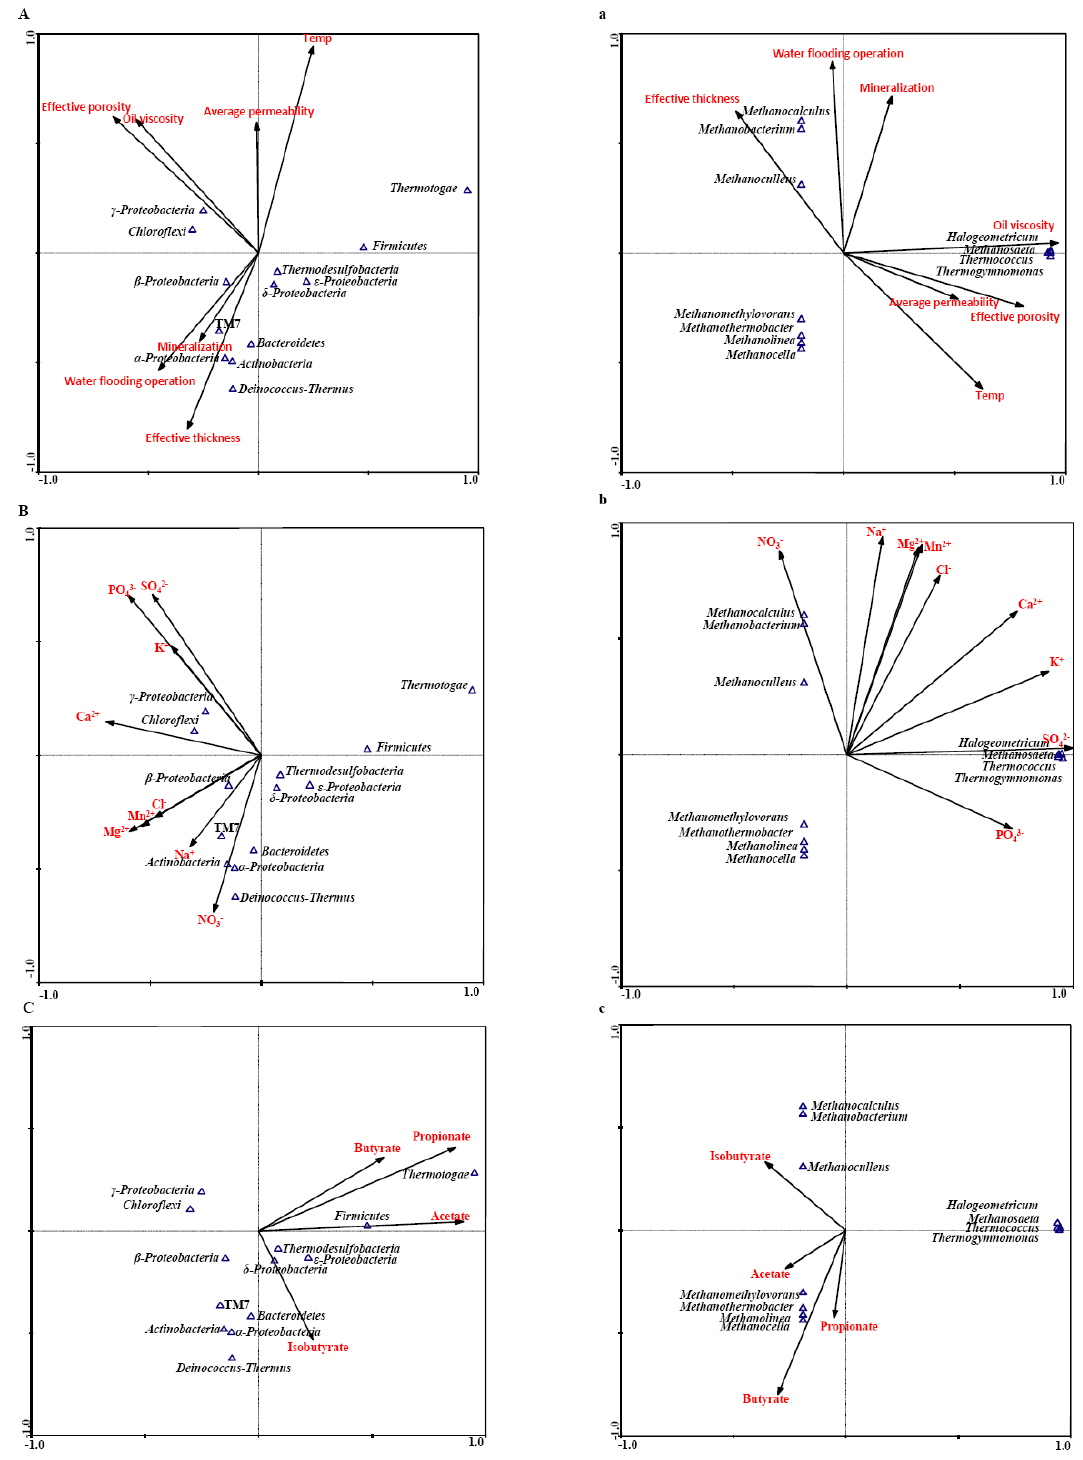
Fig. 7. CCA ordination plots for the first two dimensions to show the relationship between the bacterial and archaeal diversity with environmental factors analyzed using a 16S rRNA gene sequence in the production water of petroleum reservoirs. Correlations between environmental variables and CCA axes are represented by the length and angle of arrows (environmental factor vectors), designated with the bacterial group was showed in (A) , (B) and (C) and designated with the archaeal group was showed in (a) , (b) and (c).